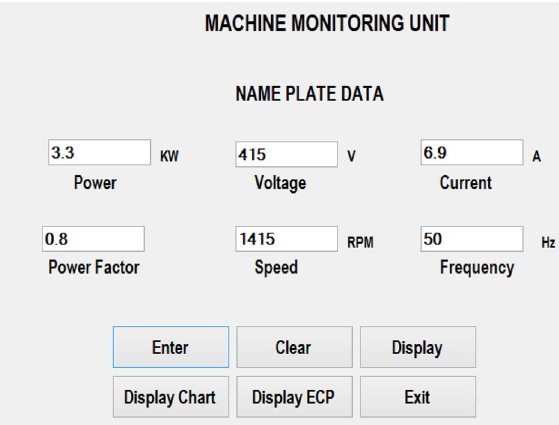
Fig. 18 MMU of VSI-IM showing motor